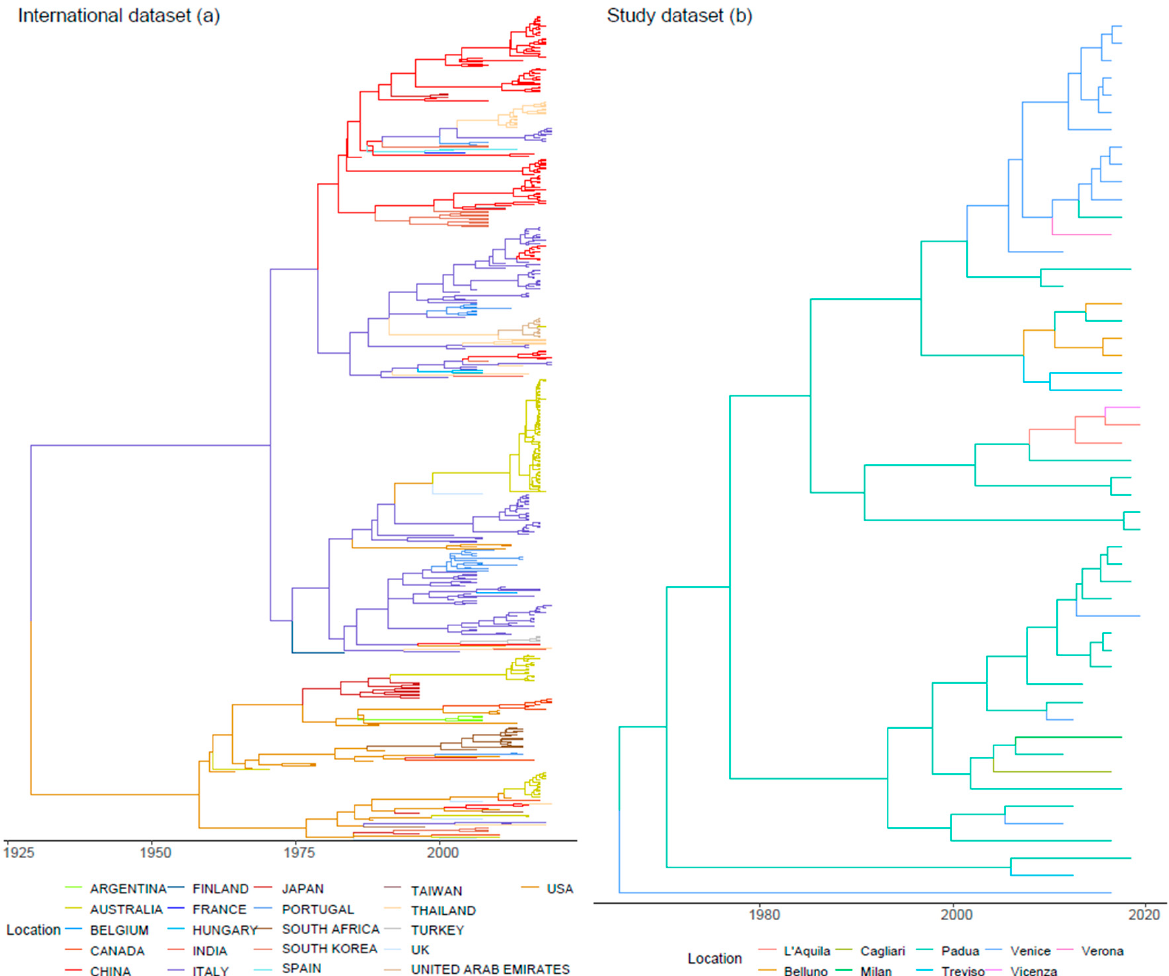
Figure 2. Maximum clade credibility tree phylogenetic trees reconstructed on the International ( a ) and Study ( b ) datasets. The geographical origin of the sequences (i.e., collection country 2a; Italian province 2b) is color-coded.